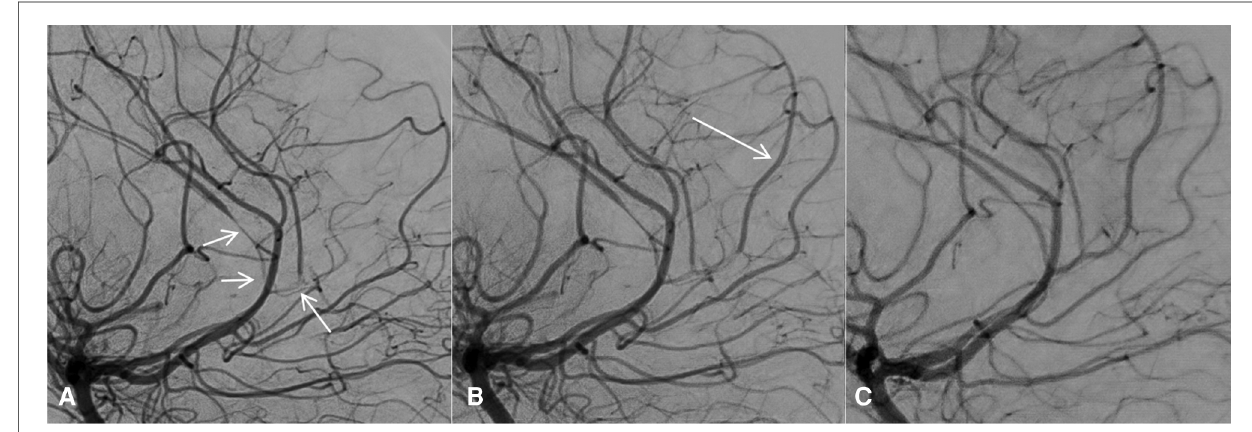
FIGURE 2 Subtracted DSA on day 12 before any vasodilator infusion ( A ) and after the fi rst vasodilator infusion ( B ). The cerebral arteries showed diffuse and severe stenosis ( A , arrows), which were improved after the fi rst intra-arterial vasodilator infusion. In particular, blood fl ow reappeared in a pericallosal branch ( B , arrow). On the last follow-up DSA, after the last vasodilator infusion 10 days after the fi rst DSA, the stenosis had almost disappeared with a near- normal appearance of the cerebral arteries ( C ). DSA, digital